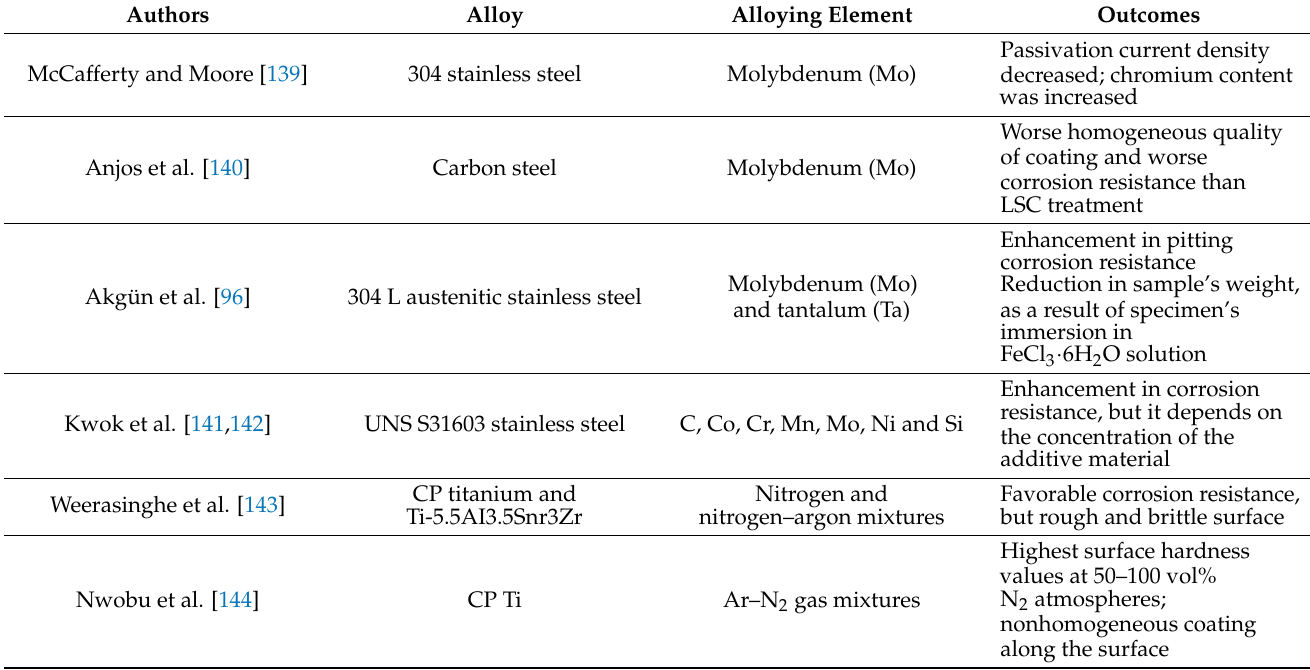
Table 9. LSA treatment on biocompatible